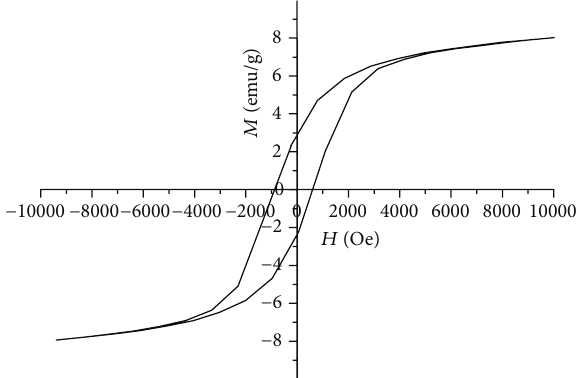
Figure 6: Magnetization of the Fe20 glass versus applied magnetic field at 4.2